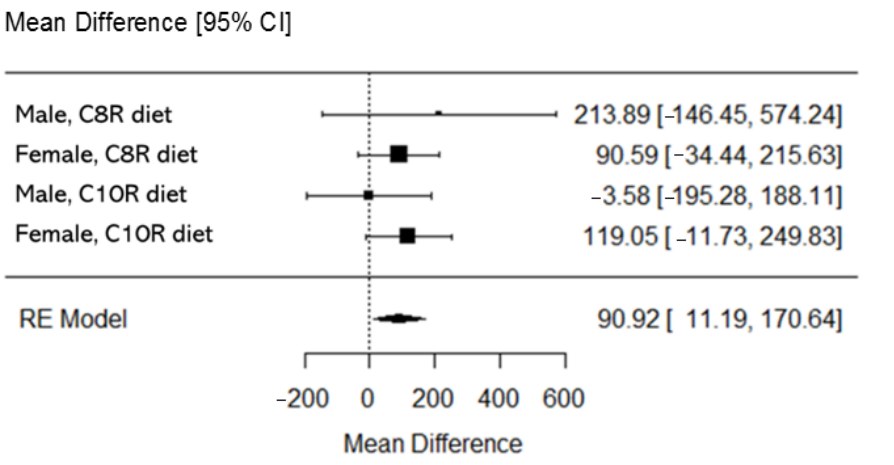
Figure 3. Pooled analysis of cumulative value of fat oxidation during overall (20Ex and InEx, ~VT) exercise in the present study. Values are mean difference and 95% coefficient interval. Random effect model with restricted maximum likelihood method was performed.